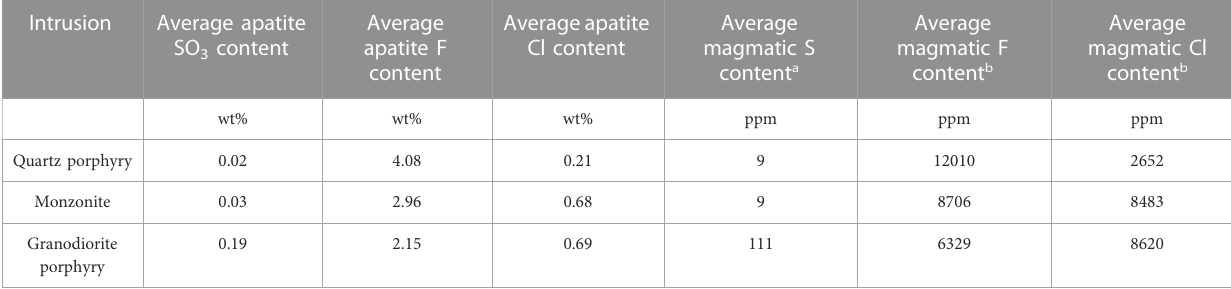
TABLE 1 Estimated S, Cl, and F contents in the porphyry-associated magma of the Kalmakyr deposit using apatite geochemical